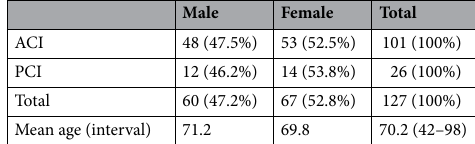
Table 1. Gender and age distribution of the